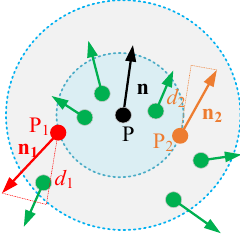
Figure 4. Diagram of the retention factor.